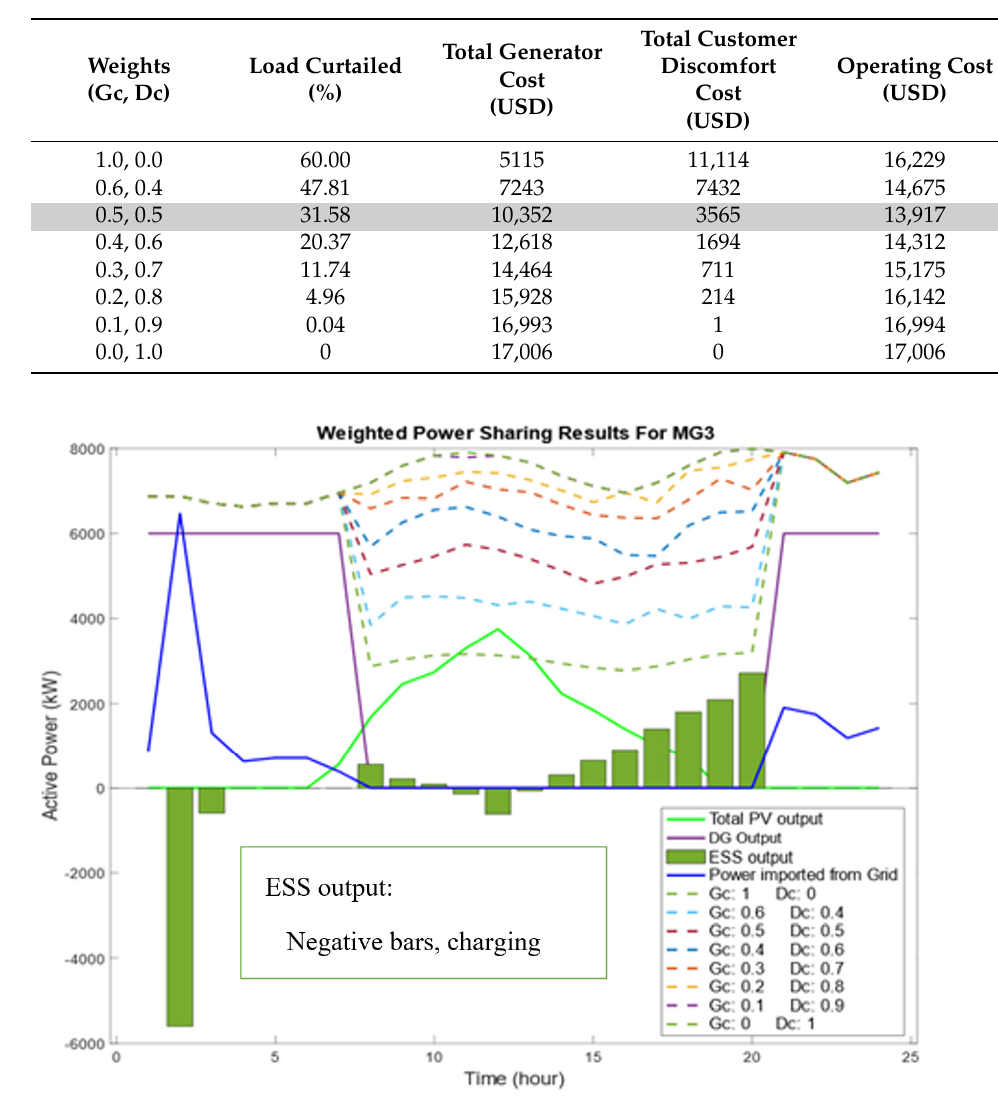
Figure 9. Weighted power request options